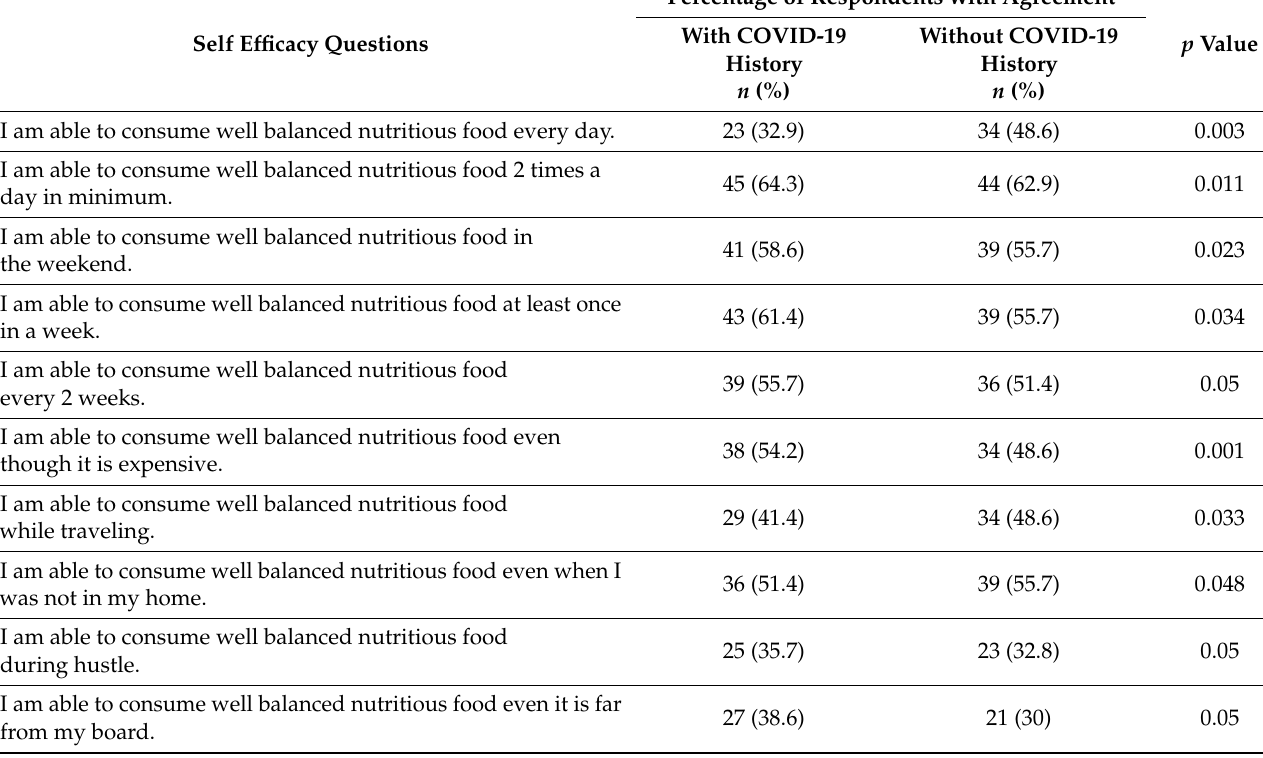
Table 6. Self-efficacy